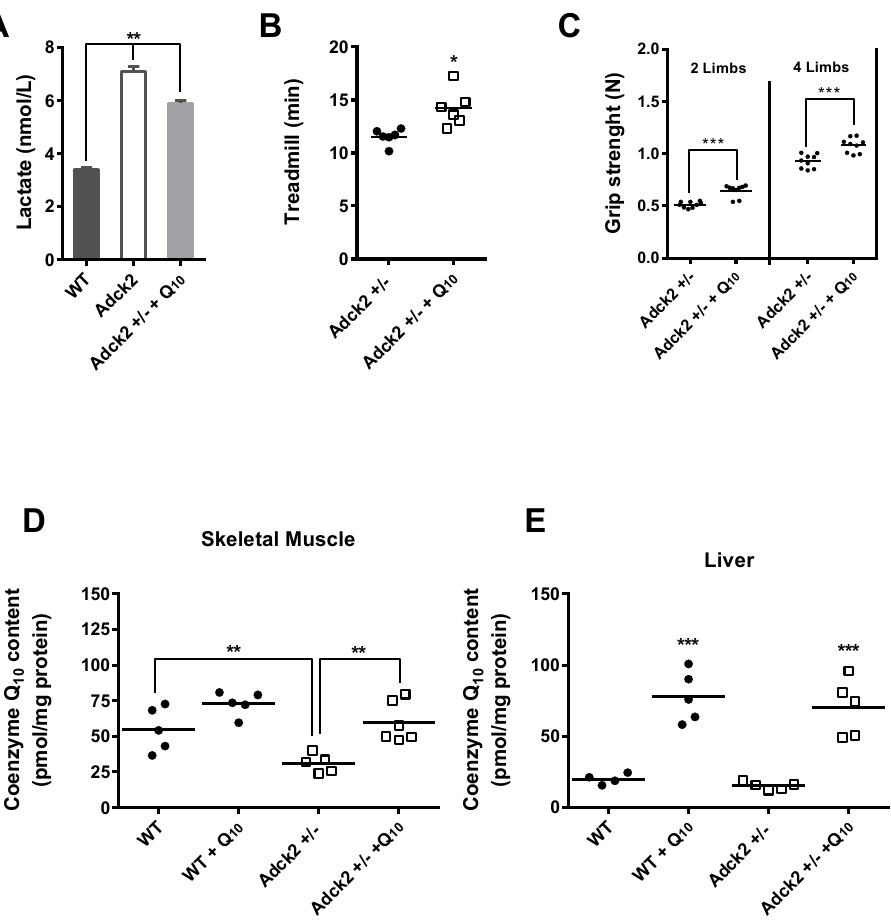
Figure 6. Supplementation with CoQ 10 partially rescued the Adck2 +/ − phenotype. ( A ) Six-month-old Adck2 +/ − mice were treated or not with 15 mg / kg of CoQ daily for three months followed by the determination of plasma lactate. ( B ) Running capacity on treadmill. ( C ) Grip strength ( n = 6). CoQ 10 content in skeletal muscle ( D ) and liver ( E ) of both WT and Adck2 +/ − mice in the absence and presence of CoQ supplementation ( n = 7). * p ≤ 0.05, ** p ≤ 0.01, *** p ≤ 0.005 vs. non-treated animals. Data were analyzed by Student’s t test.